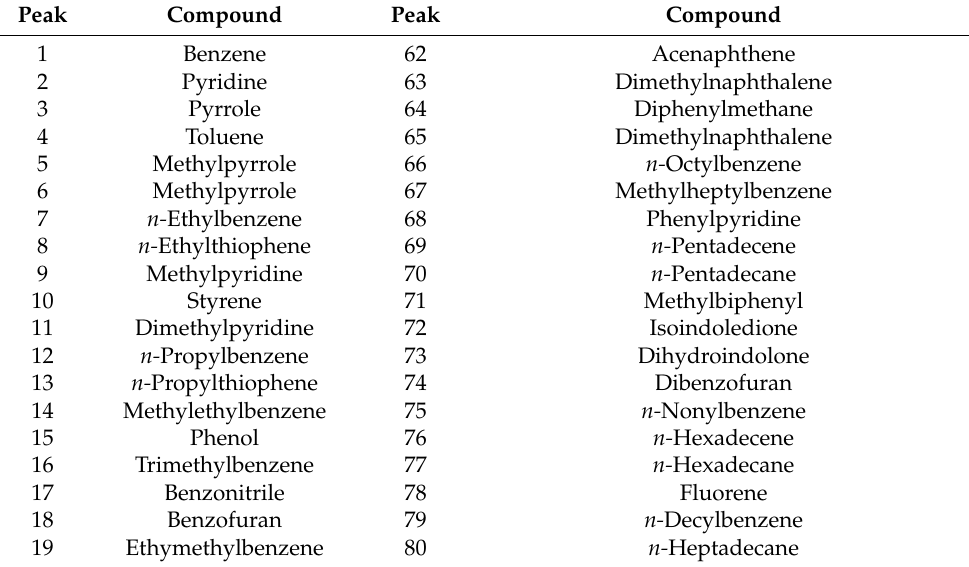
Figure 3. Untreated and acid hydrolyzed Ochroconis lascauxensis melanin pyrolyzed at 500 ◦ C (second shot). Peaks refer to Table 3. Table 3. Pyrolysis products obtained in the pyrolysis at 500 ◦ C (second shot) of the untreated and acid hydrolyzed Ochroconis lascauxensis melanin.